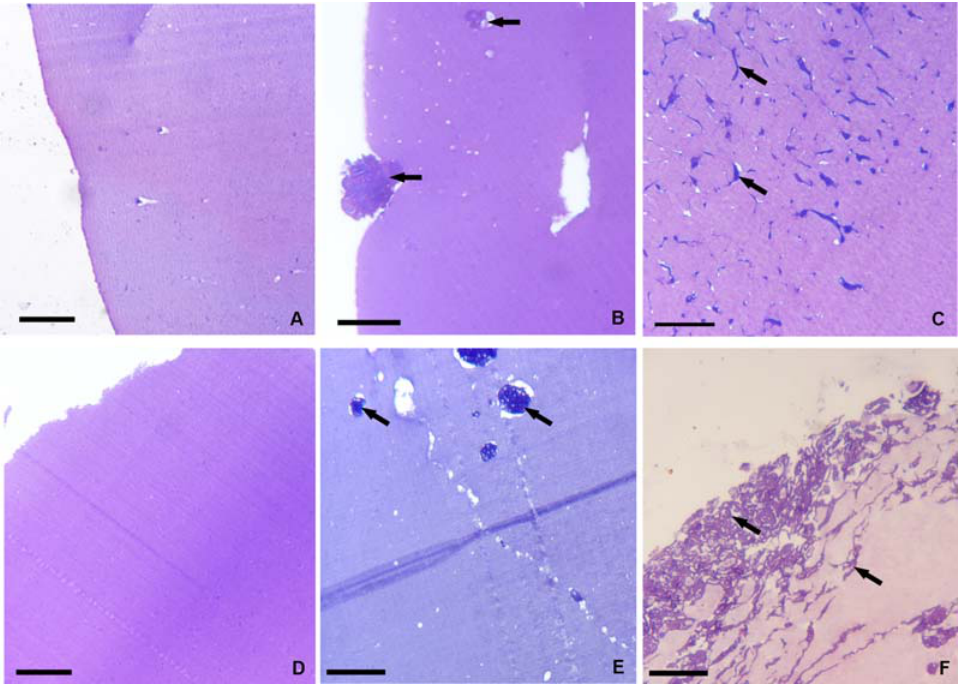
Figure 1. Histology of matrigel sponges invivo . The cells infiltrating the gels without (A, D) and with the cytokines -VEGF (B, C) or MCP-1/CCL2 (E, F) after 48 h (A, B, E) and 1 week (D, C, F). The two cytokines selectively recruit different cellular types. Bars: A–F, 20 m m